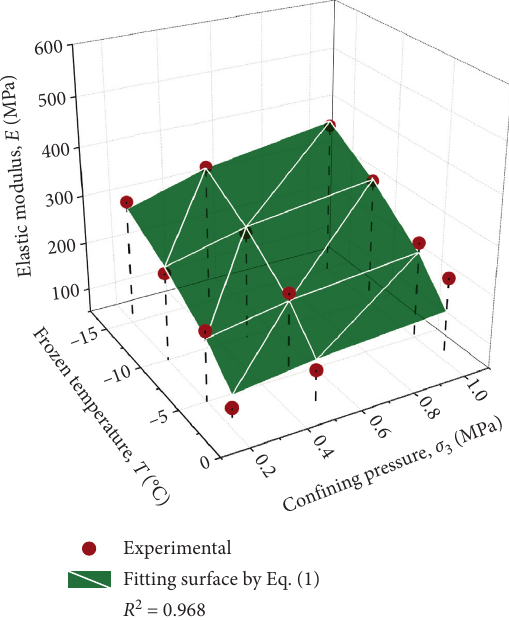
Figure 5: Variation in elastic modulus versus frozen temperature and confining